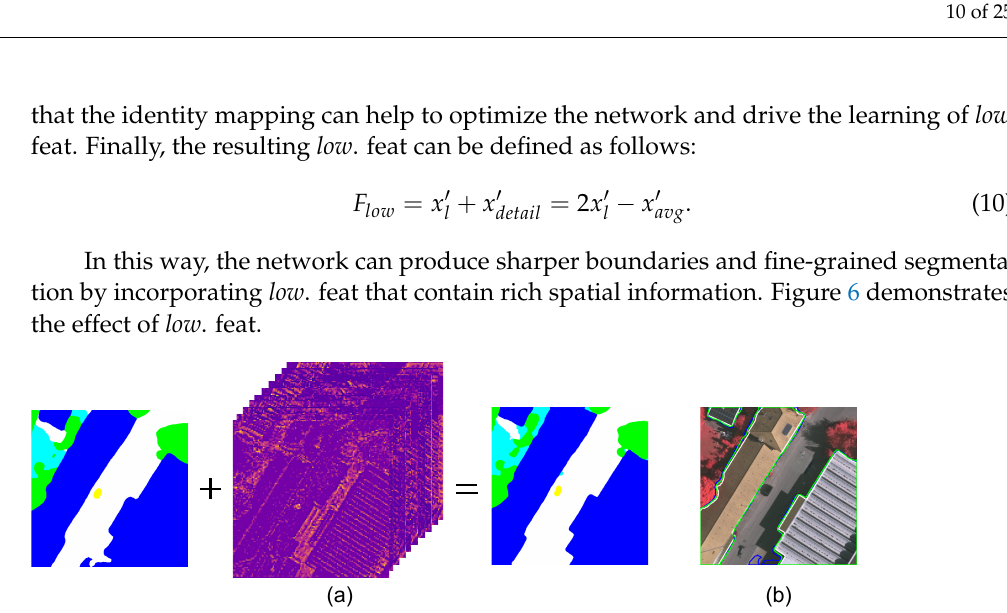
Figure 6. Visualization of the effect of low . feat. ( a ) Pipeline of baseline with addition of low . feat. ( b ) Comparison of prediction with and without low . feat, where green line represents predicted object boundaries with low . feat, while blue line shows without low . feat. The true boundaries are marked by the white